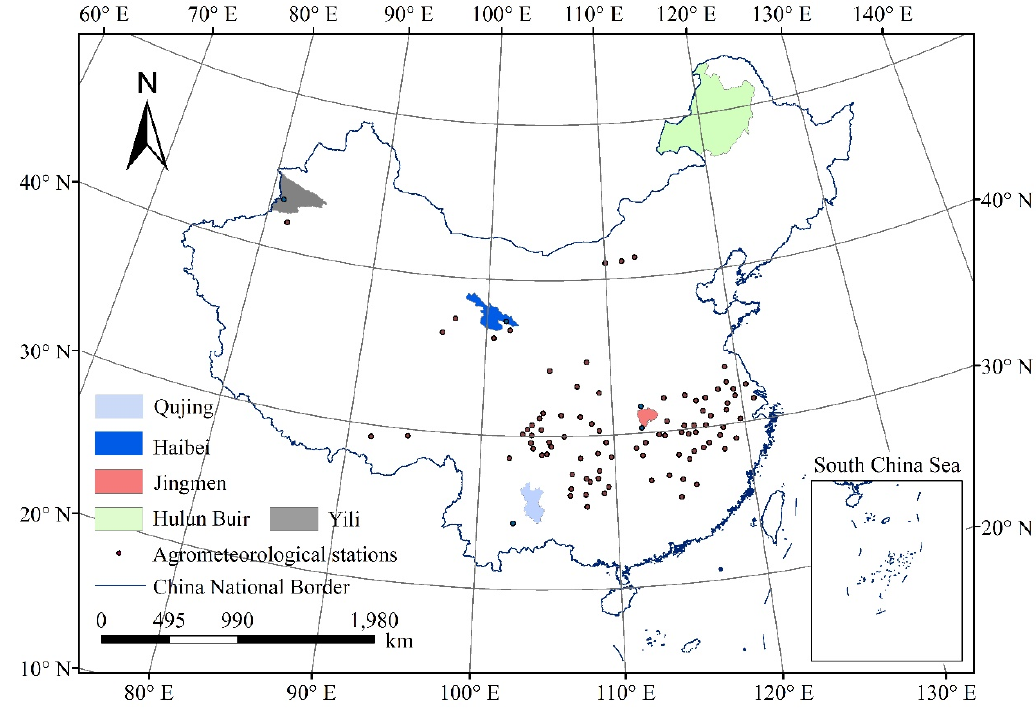
Figure 1. Study areas and location of agrometeorological stations.